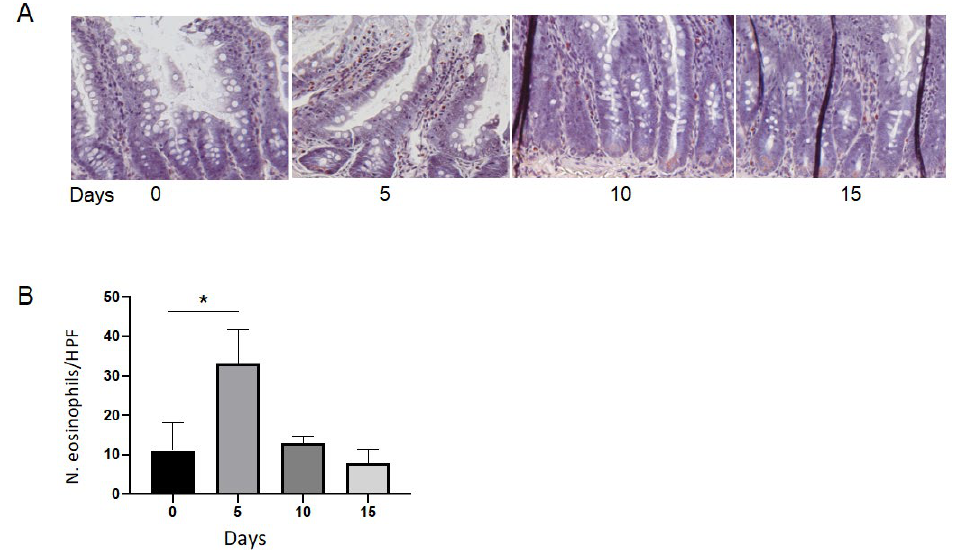
Figure 3. Caffeine triggers eosinophilic infiltration in the mucosa of intestine in rats. Rats assumed a beverage containing caffeine for five days, followed by ten days without assumption. ( A ). Representative Pagoda red staining of intestine sections before caffeine assumption (0), after 5 days of treatment (5), after five more days without caffeine assumption (10) and after ten days without caffeine assumption (15). ( B ). Histogram showing the number of eosinophils per HPF at the same time points. Data are median ± interquartile range of five independent counts on five animals. * = p < 0.05.